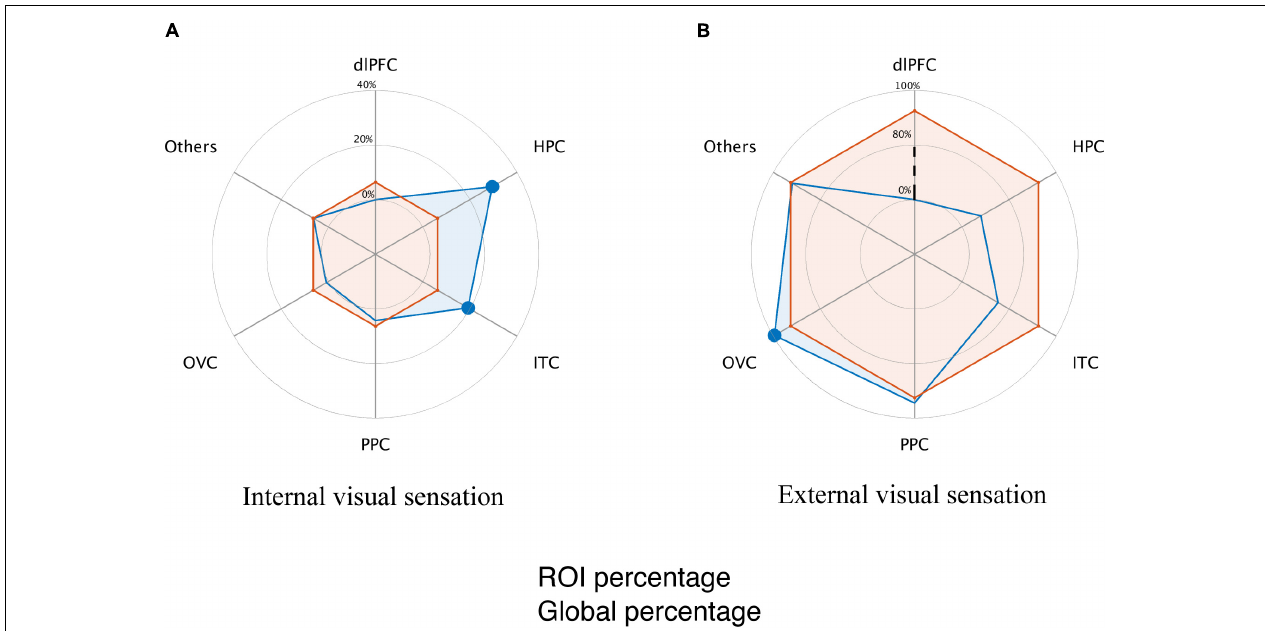
FIGURE 3 | Dissociated brain module involvement in involuntary visual imagery and hallucination. (A) Global and module internal visual response percentage. The orange line indicates the average proportion of internal visual responses relative to all the elicited visual responses. The blue line indicates the proportion of internal visual responses within a specific module. (B) Global and module external visual response percentage. The orange line indicates the average proportion of external visual responses relative to all the elicited visual responses. The blue line indicates the proportion of external visual response within a specific module. The dashed black line indicates that the response percentage did not scale linearly for illustration. The modules with a filled large circle exhibit a significantly higher percentage than that of the cortical average ( p < 0.01, Binomial test, Bonferroni correction for multiple